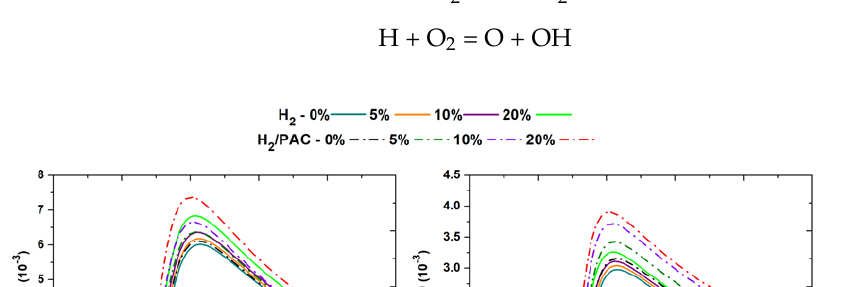
Figure 9. Comparison of atomic excited species O(1D) at various equivalence ratios using different H 2 contents with NSPD.